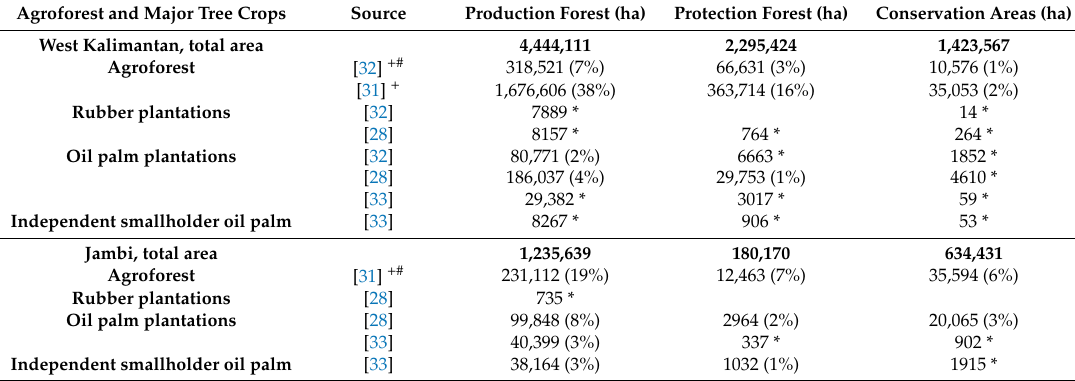
Table 3. Areas of agroforest and major tree crops in West Kalimantan and Jambi in 2018–2019. Agroforest and Major Tree